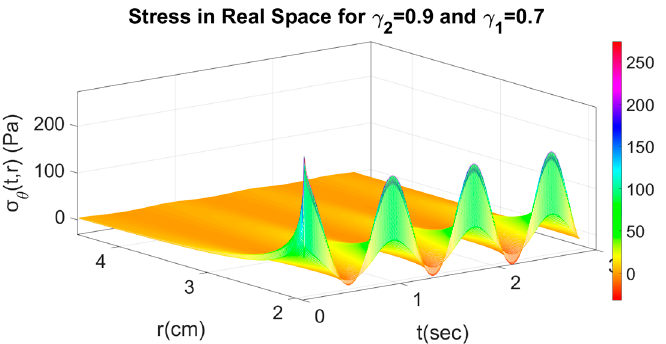
Figure 15. Distribution of the stress σ θ ( t , r ) in the initial space with space (porosity) fractional order γ 1 = 0.7 and time fractional order γ 2 = 0.9.